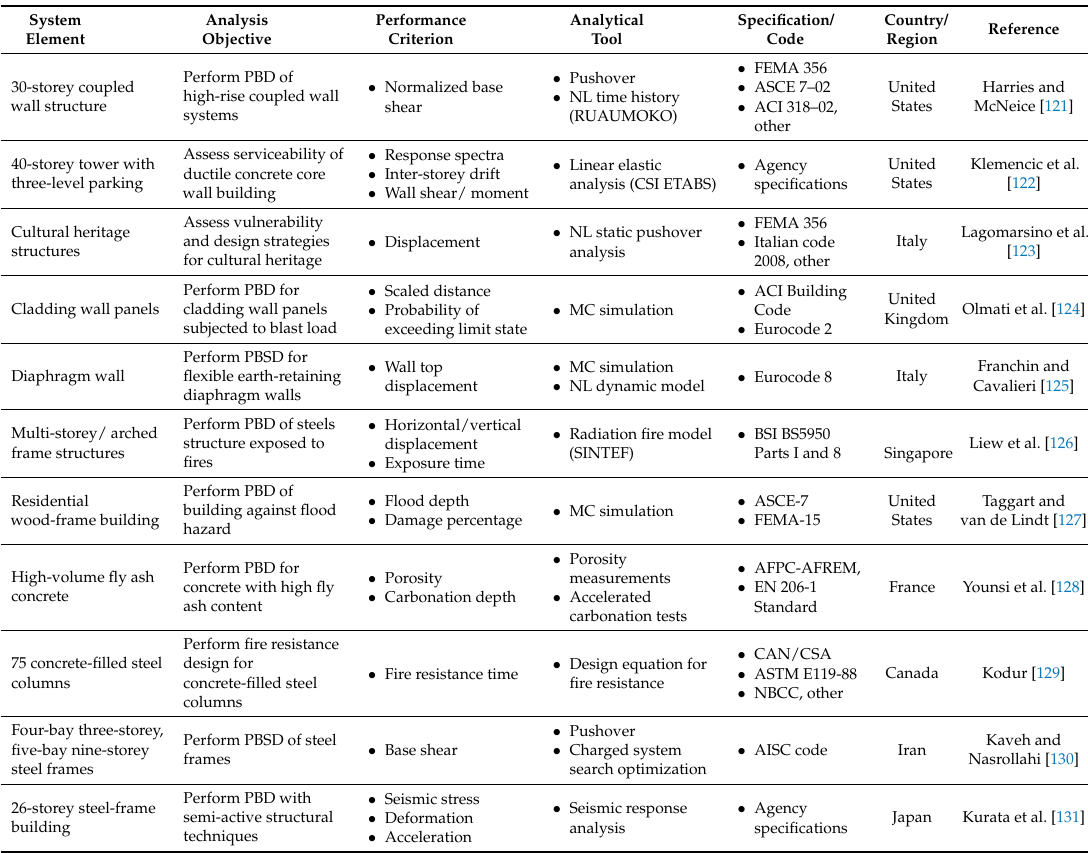
Table A9. Characteristics of building earthquake-based design applications (special